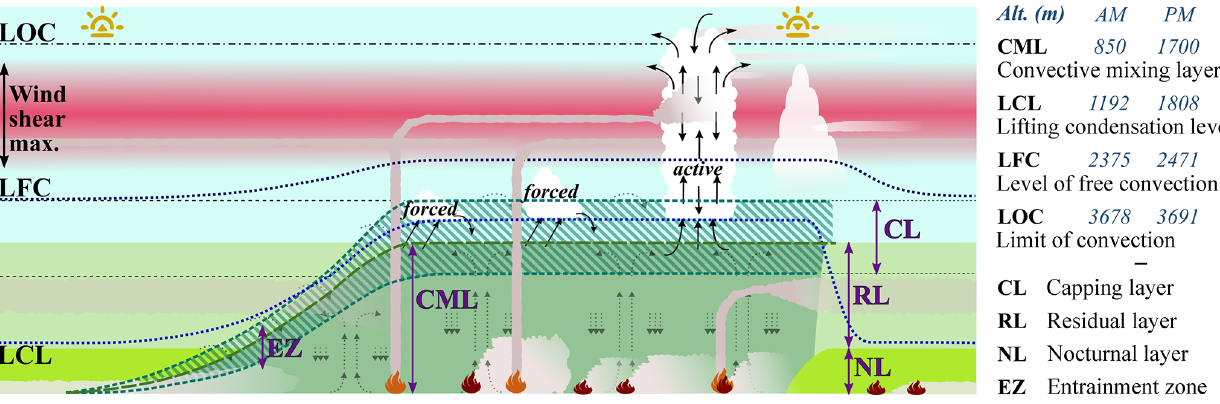
Figure 2. Schematic of the typical diurnal development of the convective boundary layer. This is based on visual and automated analysis of individual profiles and, for the nocturnal period outside our sampling times, previous tropical boundary layer literature. Red flame symbols indicate more smouldering fires and orange symbols more flaming